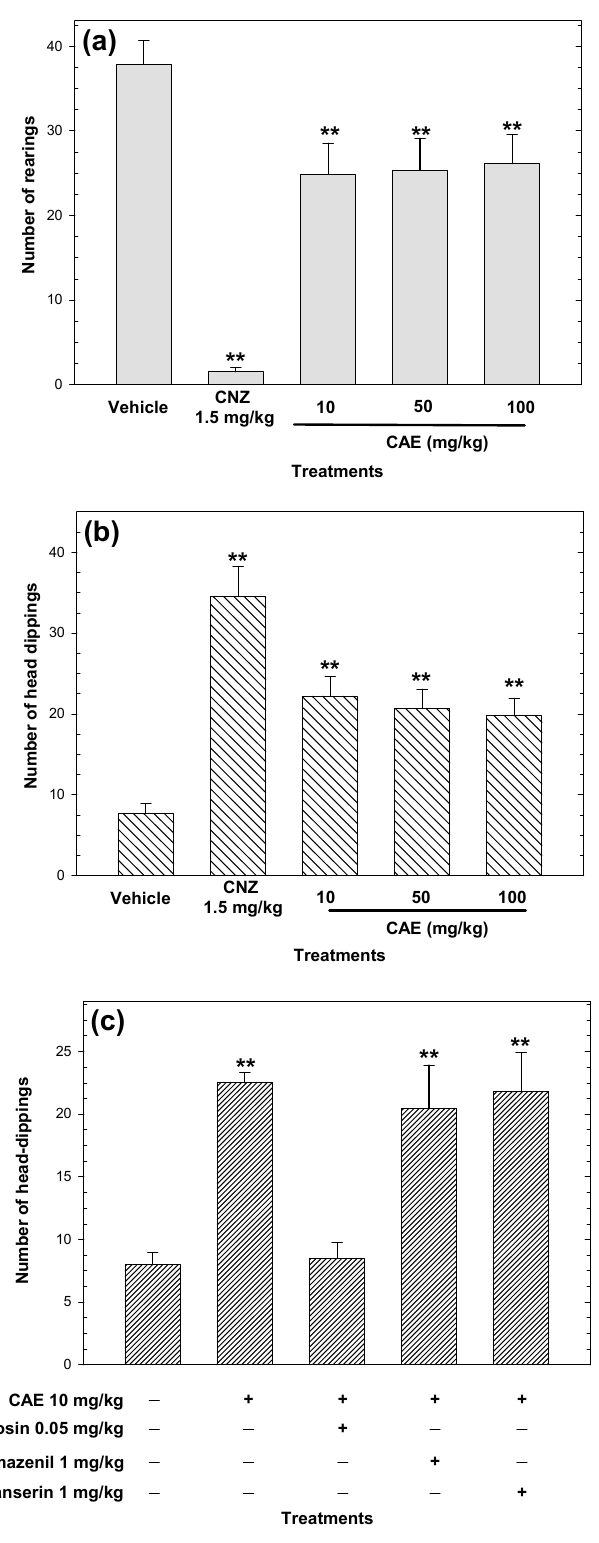
Figure 5. Anxiolytic-like effects of CAE (10–100 mg/kg p.o.) were measured in the cylinder exploratory test ( a ) and the hole-board test ( b ) during a 5 min exposure. The possible mechanism of action of CAE was evaluated in the hole-board test ( c ). Clonazepam (CNZ) at 1.5 mg/kg p.o. was used as the positive control. Bars represent mean values ( ± SEM) for the experimental group. n = 8, ** p < 0.05 compared to the vehicle group.